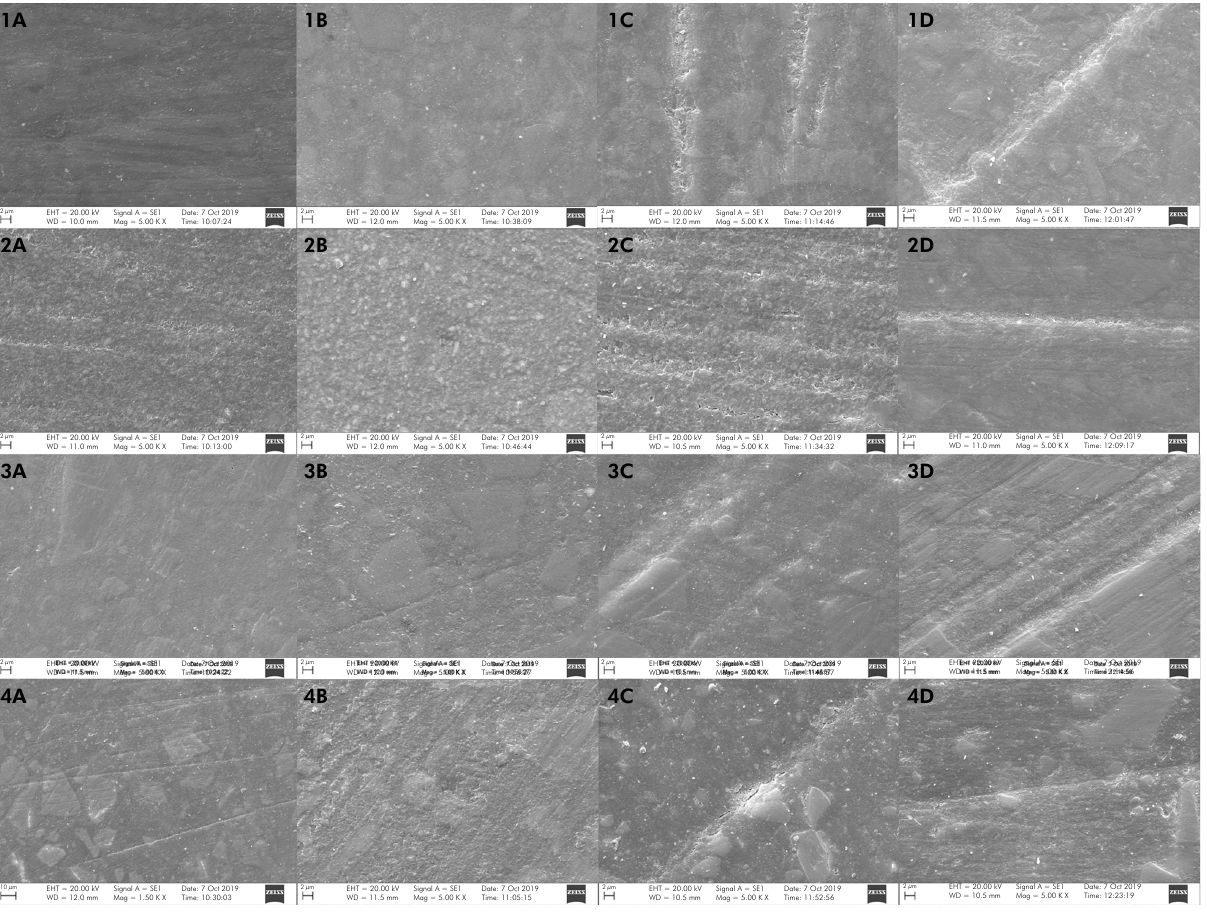
Figure 3. Scanning electron microscopy representative images of resin composite surfaces after being modeled with coatings at 5000x. Line 1: Control group; Line 2: Wetting resin; Line 3: Scotchbond adhesive; Line 4: Universal adhesive. The letters corresponded to baseline (a), after staining - (T1) (b), after 5,000 cycles - (T2) (c) and after 10,000 toothbrushing cycles - (T4)